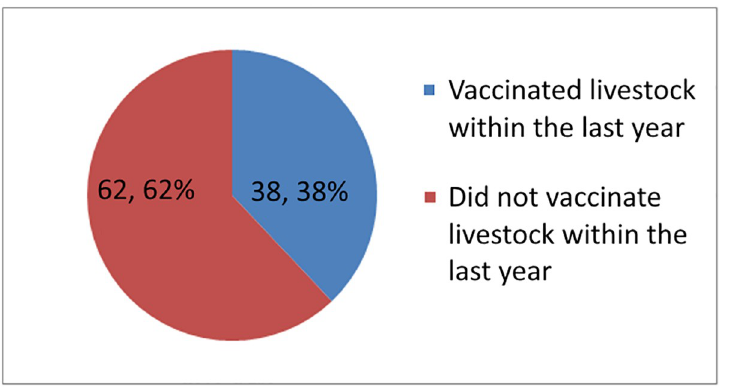
Fig 4. Number of respondents that vaccinated livestock in the last